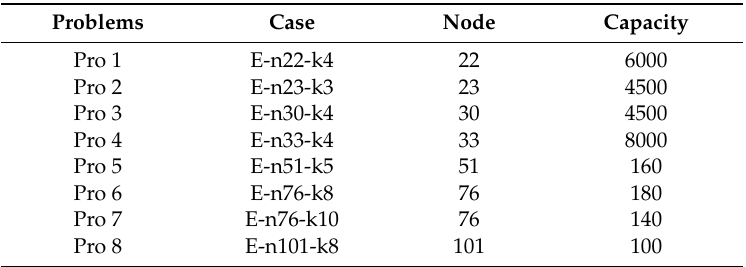
Table 5. Data about the test instances.